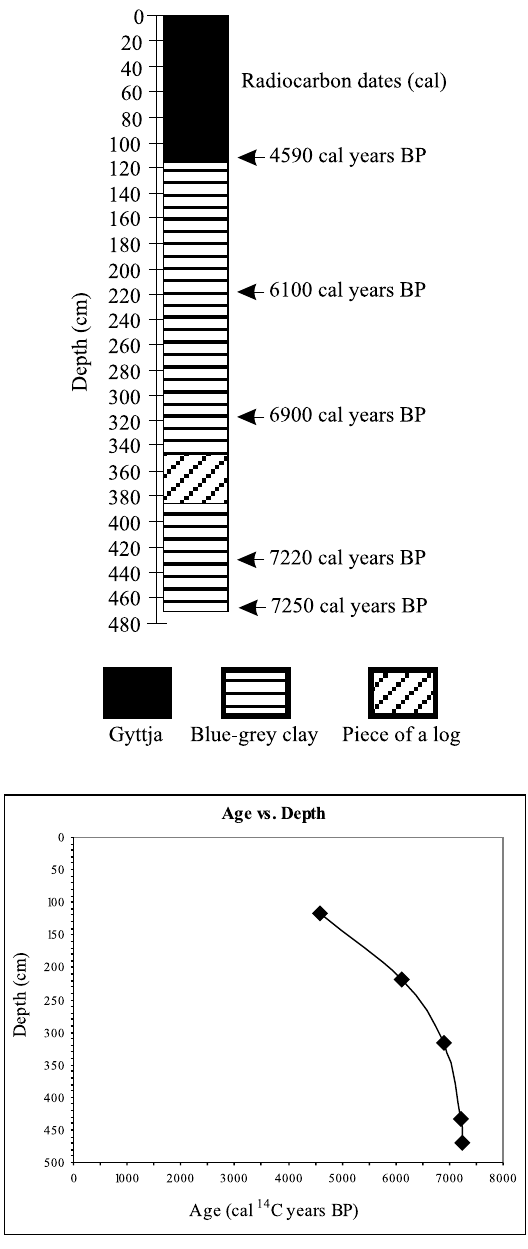
Fig. 2–LithologyofsedimentcorefromLakeMárcio,Amapá(Brazil). Also showing location of dated samples in cal yrs BP (top). Radiocar- bon ages from Lake Márcio plotted against depth (cm)